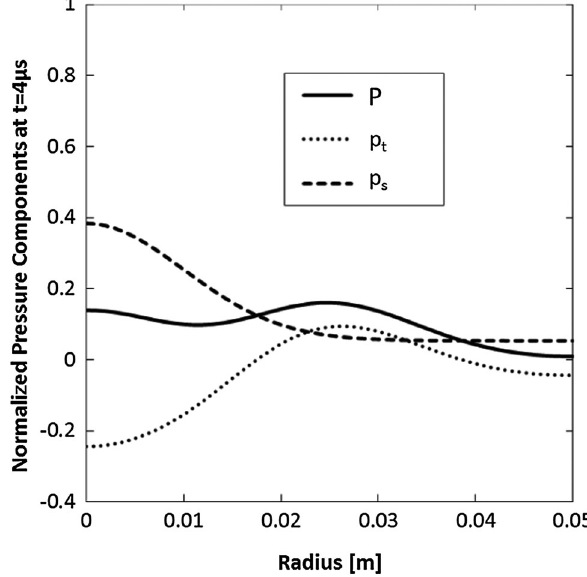
8. Pressure wave components at t ¼ 0 for the test case assuming plane stress.